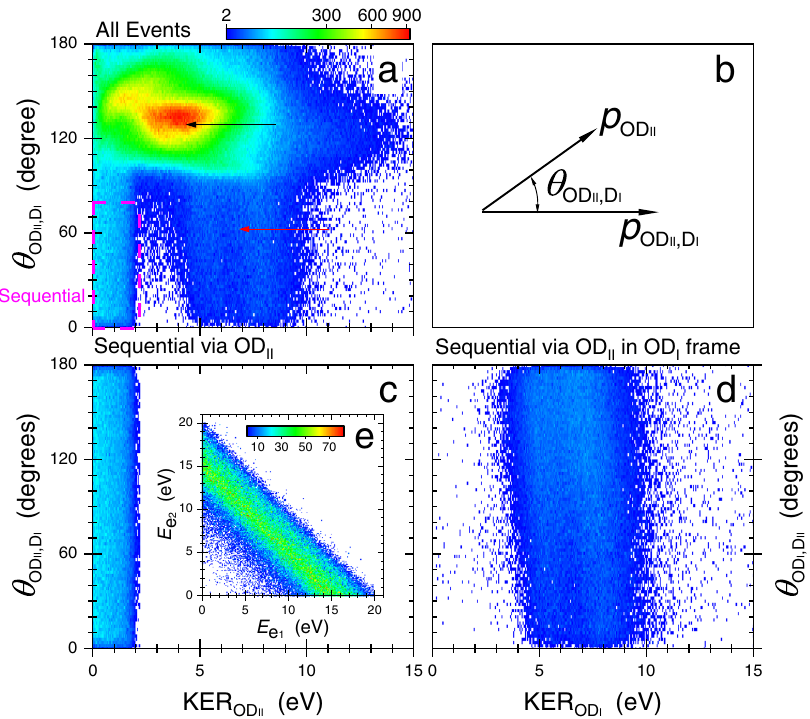
Fig. 2 | Native frames analysis of D + +D + +O breakup. a All the measured ffiffiffiffiffiffiffiffiffiffiffiffiffiffiffi p counts scale)asafunctionofthekineticenergy D + +D + +Oevents(shownusinga , and the angle between the conjugate released upon OD + II dissociation, KER OD II momenta, θ OD . Sequential fragmentation events via D + I +OD + II are identi fi ed II ,D I